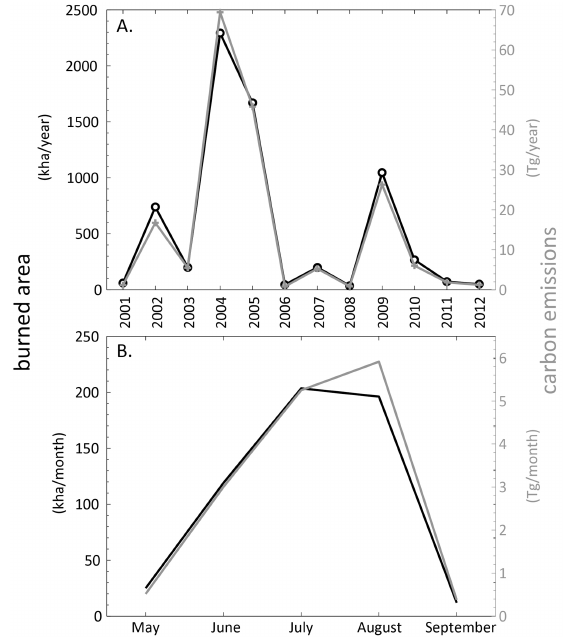
Figure 7. (a) Inter- and (b) intra-annual variability in burned area and carbon emissions in Alaska. In (b) , the mean monthly burned area and carbon emissions between 2001 and 2012 were plotted.